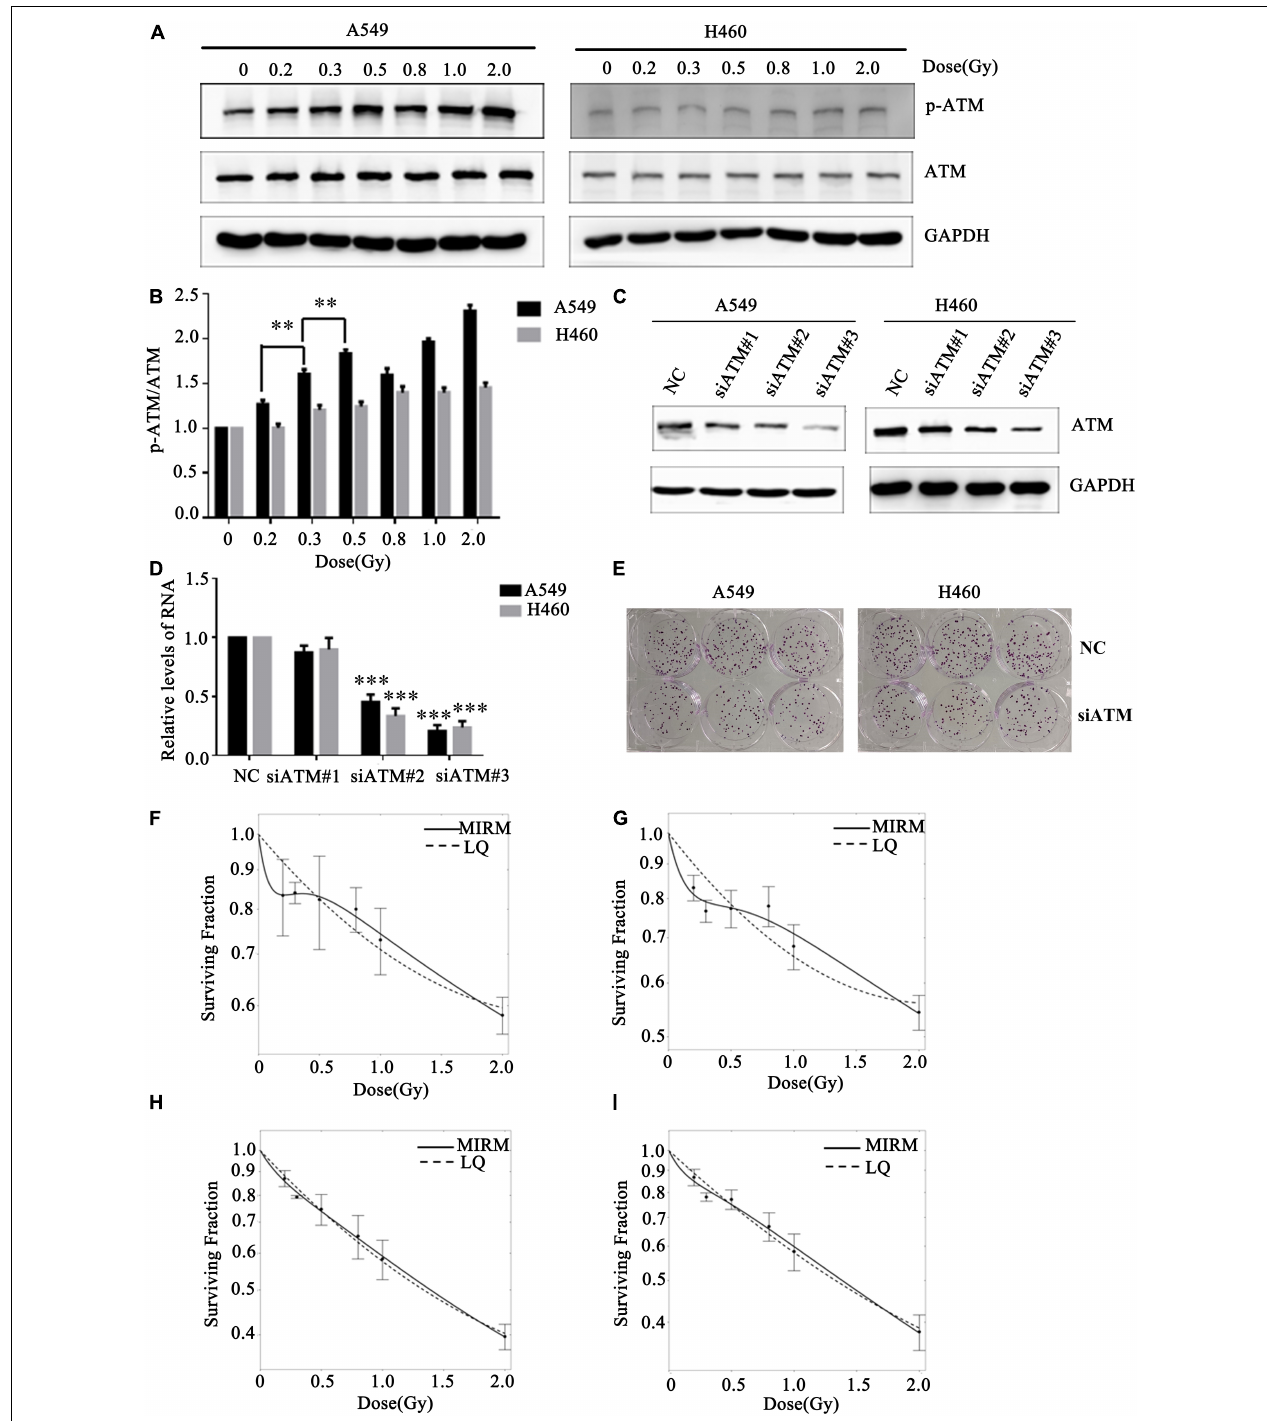
FIGURE 2 | Effect of ATM on the low-dose radiosensitivity of A549 and H460 cells. (A,B) Level of p-ATM in A549 and H460 cells under low-dose radiation. (C,D) siRNA transfection knocked down ATM gene expression in A549 and H460 cells. (E) Decreasing the expression of ATM inhibited the proliferation of A549 and H460. (F) The survival curve of A549 cells fitted by MIRM showed the HRS/IRR phenomenon. (G) The HRS phenomenon of A549 cells was enhanced after ATM knockdown. (H) The survival curves of H460 cells were in line with the traditional LQ model. (I) Radiosensitivity was enhanced in H460 cells after ATM knockdown. *** p < 0.001, ** p <